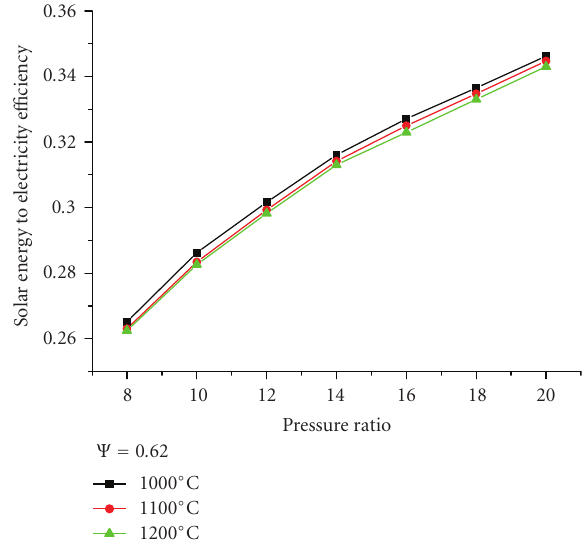
Figure 5: Solar energy to electricity e ffi ciency variation with pressure